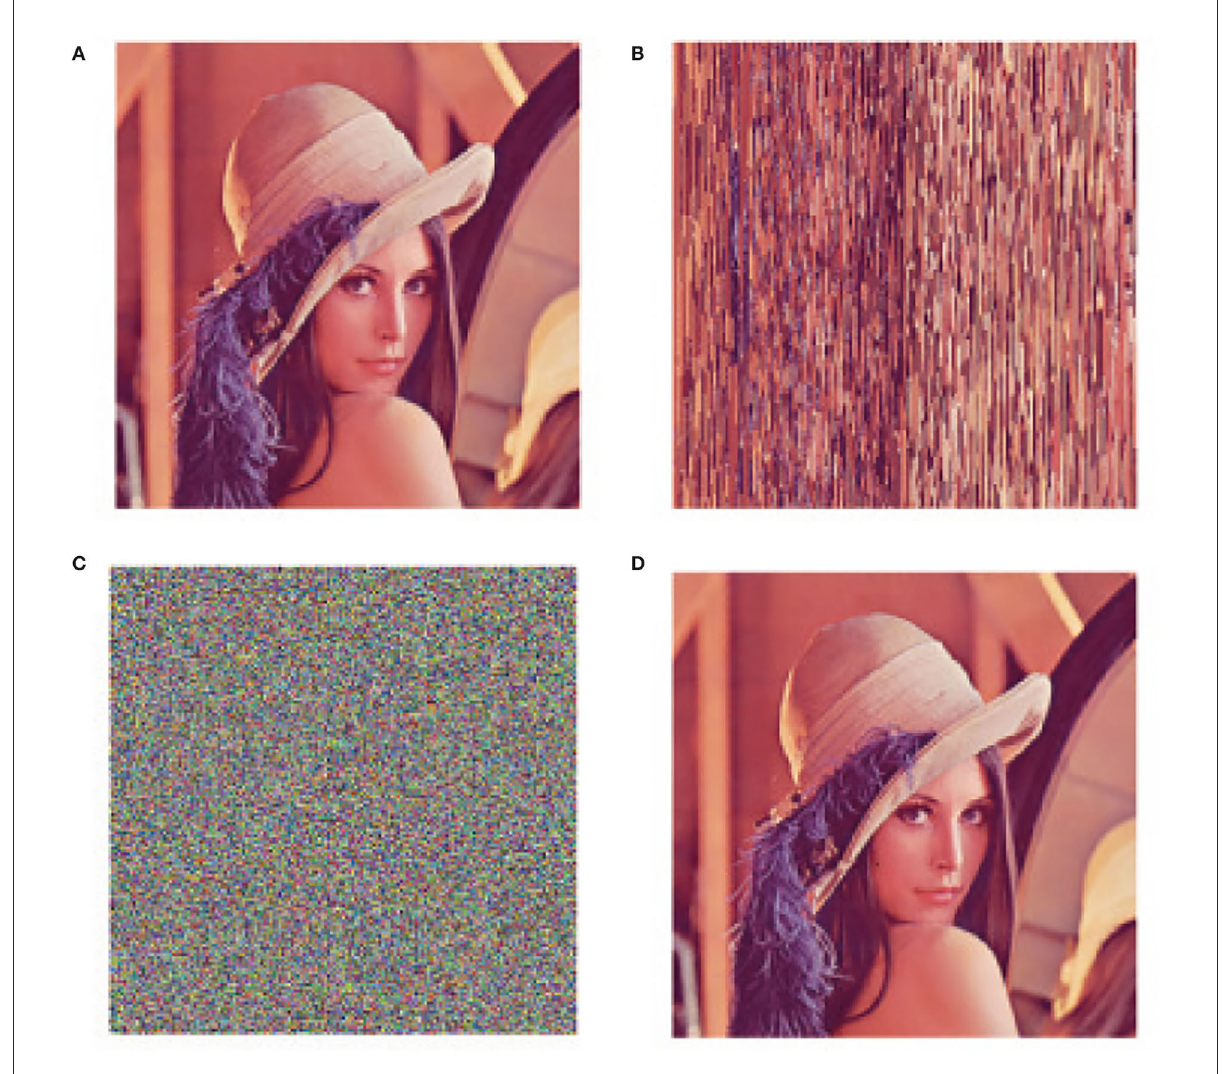
FIGURE8 Original encryption and decryption pictures. (A) Original picture “Lena.” (B) Pixel scrambling picture. (C) The encrypted picture. (D) The decrypted picture (This image is taken from a public